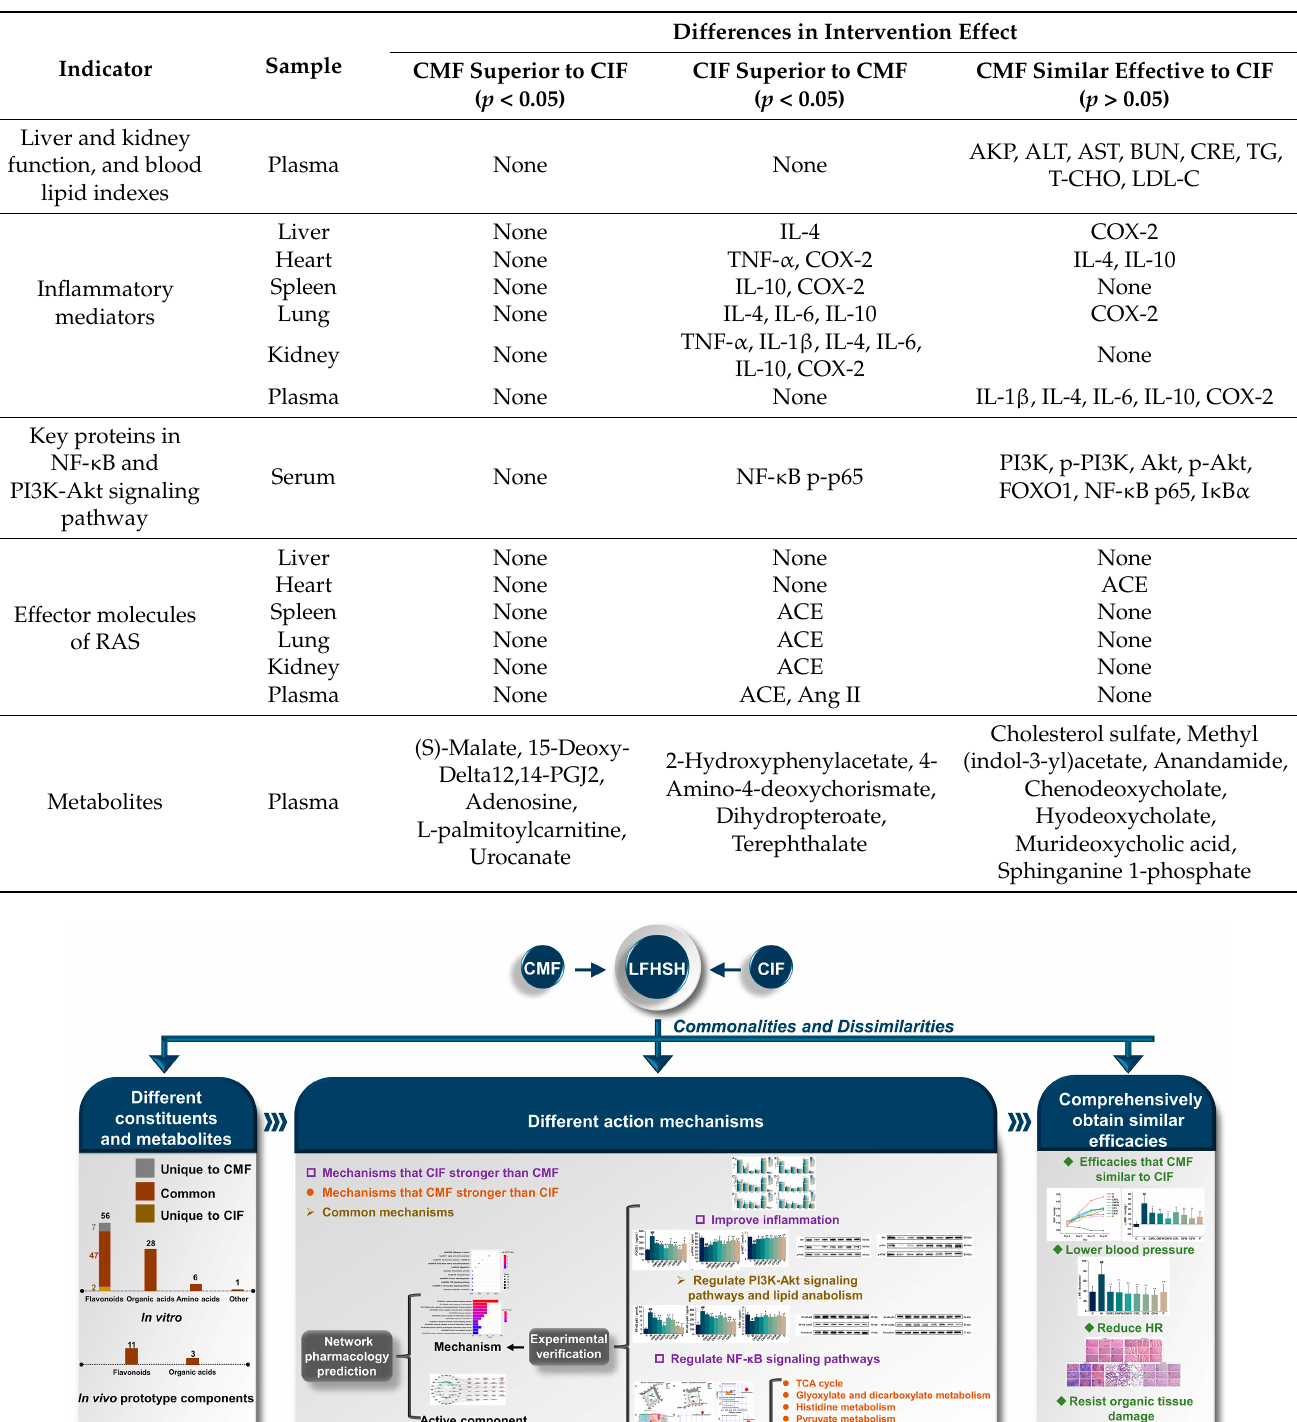
Table 1. The differences in intervention effects on measurement indicators between CMF and CIF.